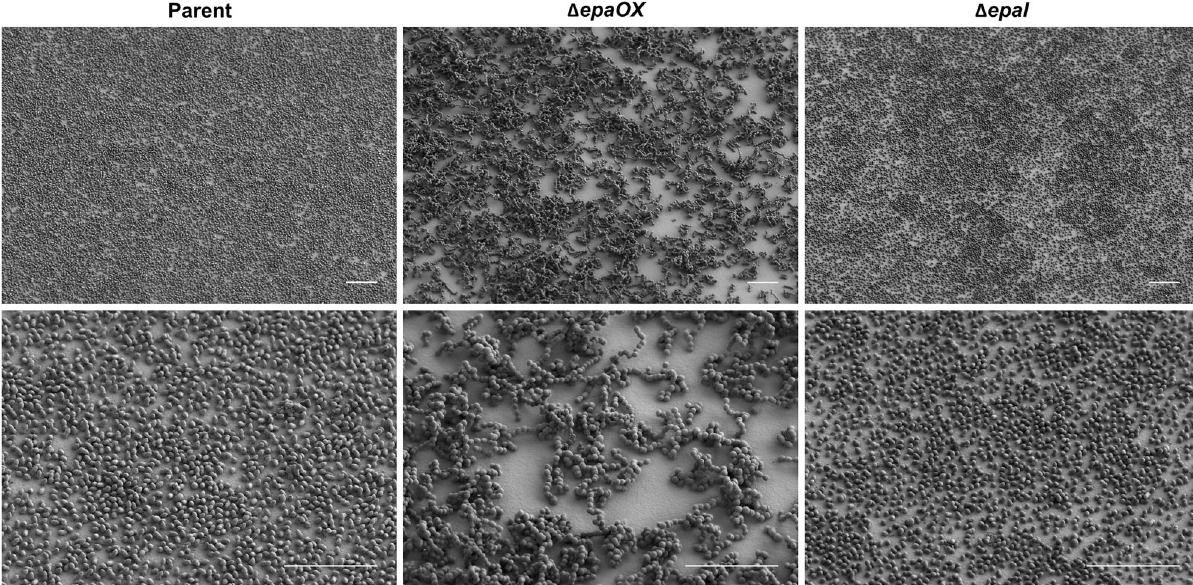
Fig. 1 Effects of epa deletions on E. faecalis bio fi lm formation. Scanning electron micrographs showing structural differences in bio fi lm architecture of parent strain OG1RF vs. isogenic epa mutants. Cultures were grown on Aclar membranes in CBRs for 24 h in the absence of antibiotics (scale bars, 10 µm). Representative images are shown from experiments performed a minimum of three times using biological